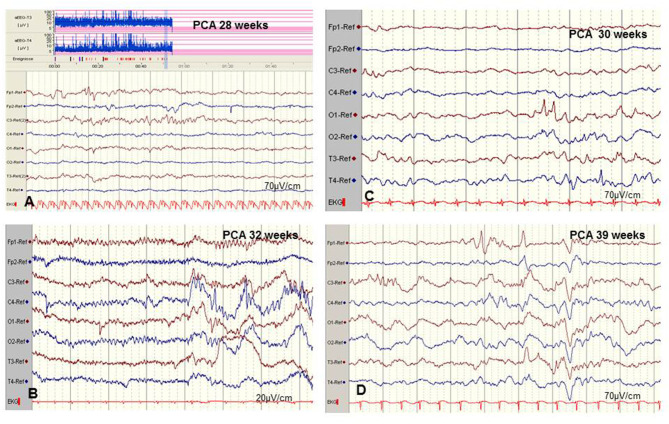
Limits of aEEG monitoring in detection of seizure activity. (A) Low-voltage and brief (<10–30 s) epileptic discharges in a preterm of 28 weeks postconceptual age (PCA) not detected by the time-compressed display. (B) Pseudosuppression of background due to artifacts of high-frequency oscillatory ventilation. (C,D) Physiological paroxysmal transients. (C) Sharp theta on the occipital area of prematures (STOP) in a preterm of 30 weeks PCA. (D) Frontal sharp theta transients and delta brushes in a term newborn. (Calibration is given in the figure, low-pass 30 Hz, high-pass 0.5 Hz).